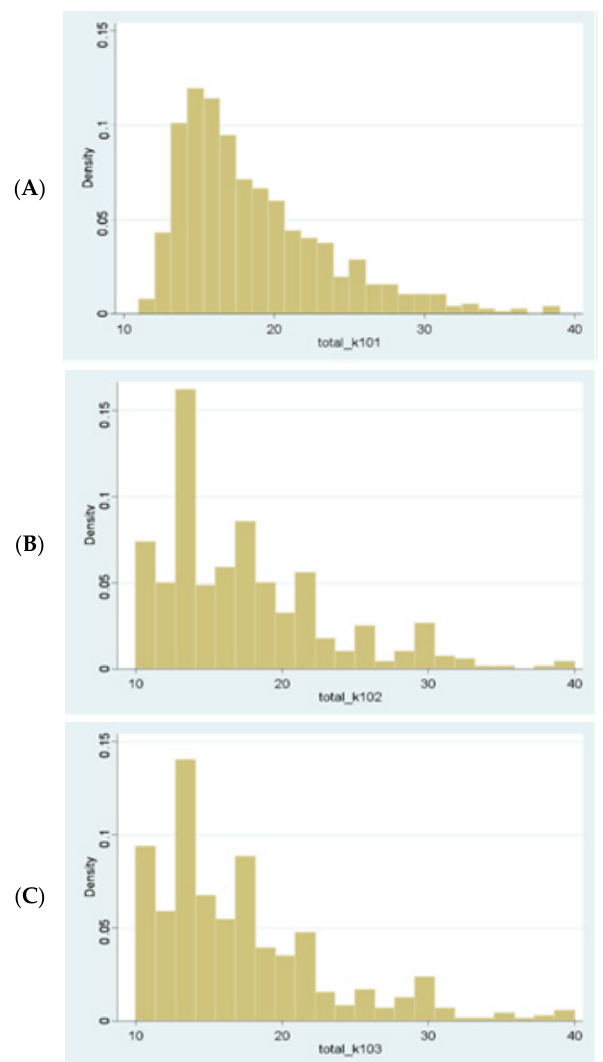
Figure A2. Distribution of the Kessler 10 Psychological Distress Scale (K10). ( A ) K10 at baseline; ( B ) K10 at 4-months (end of the program); ( C ) K10 at 12-months (8-months after program completion).